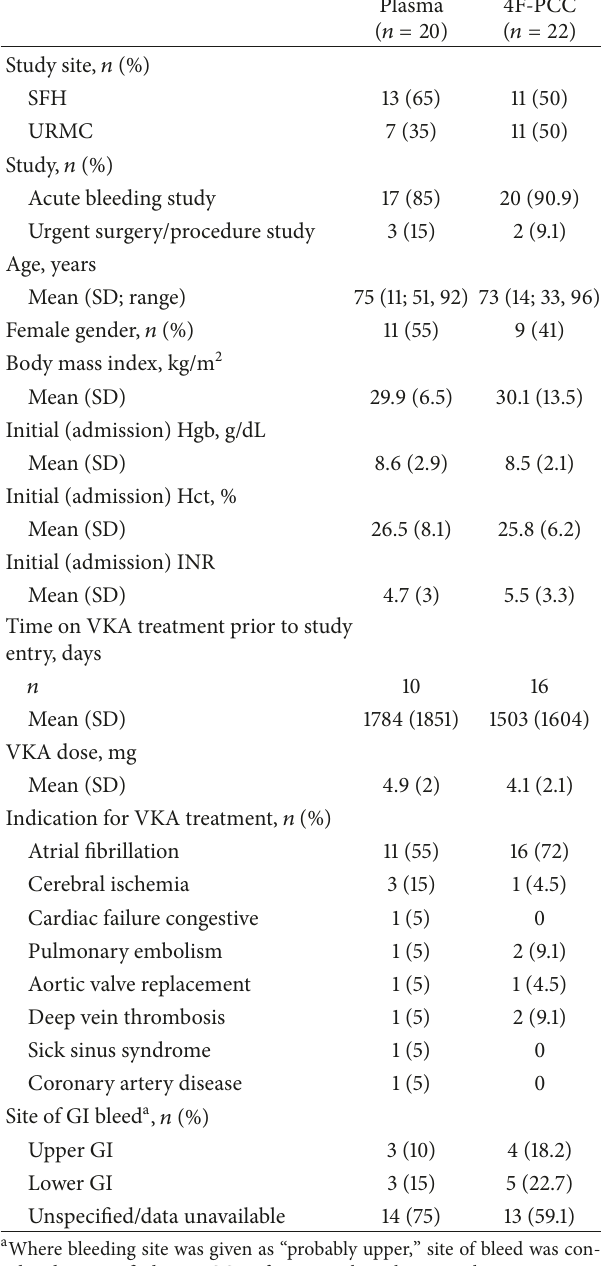
Table 2: Patient demographics and baseline disease